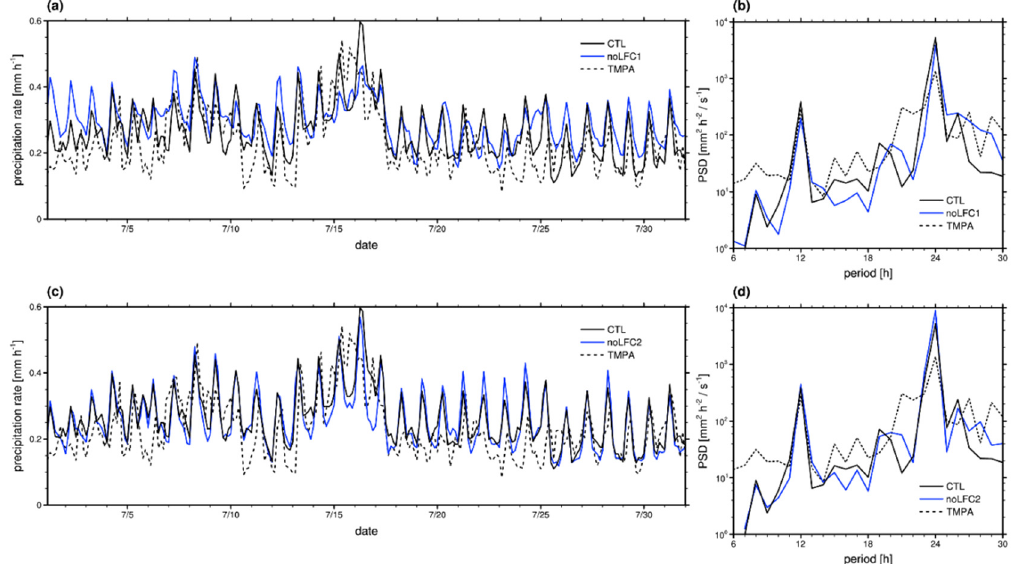
Figure 5. Time series of spatially averaged precipitation rate (mm h − 1 ; left ) and PSD of precipitation rate plotted on a logarithmic scale as a function of period (mm 2 h − 2 /s − 1 ; right ) for July 2006 over the East Asian land area from the TMPA observation (dashed line), experiment without the LFC1 trigger condition (blue solid line; top ), and experiment without the LFC2 trigger condition (blue solid line; bottom ). The result of the CTL experiment is also plotted for comparison as a black solid line.